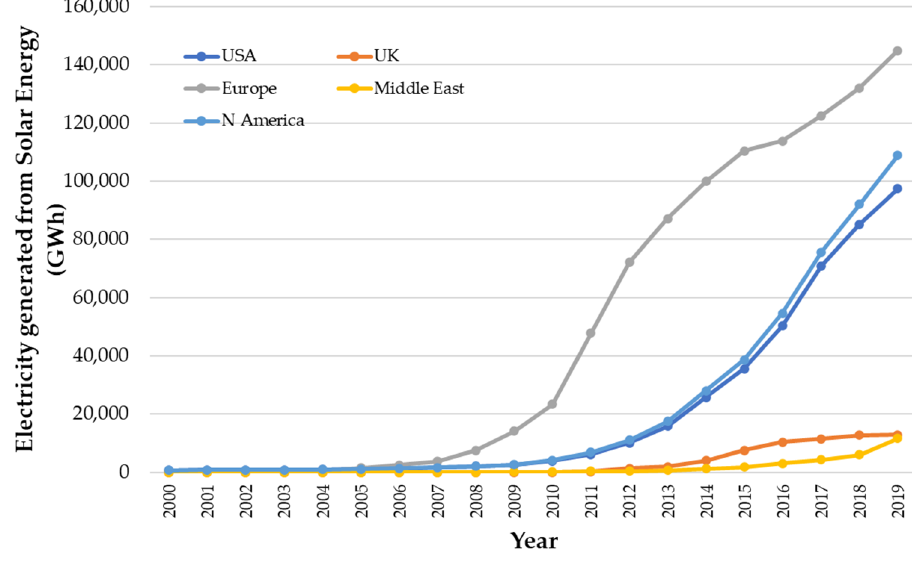
Figure 1. Increase in solar power generation worldwide [9].